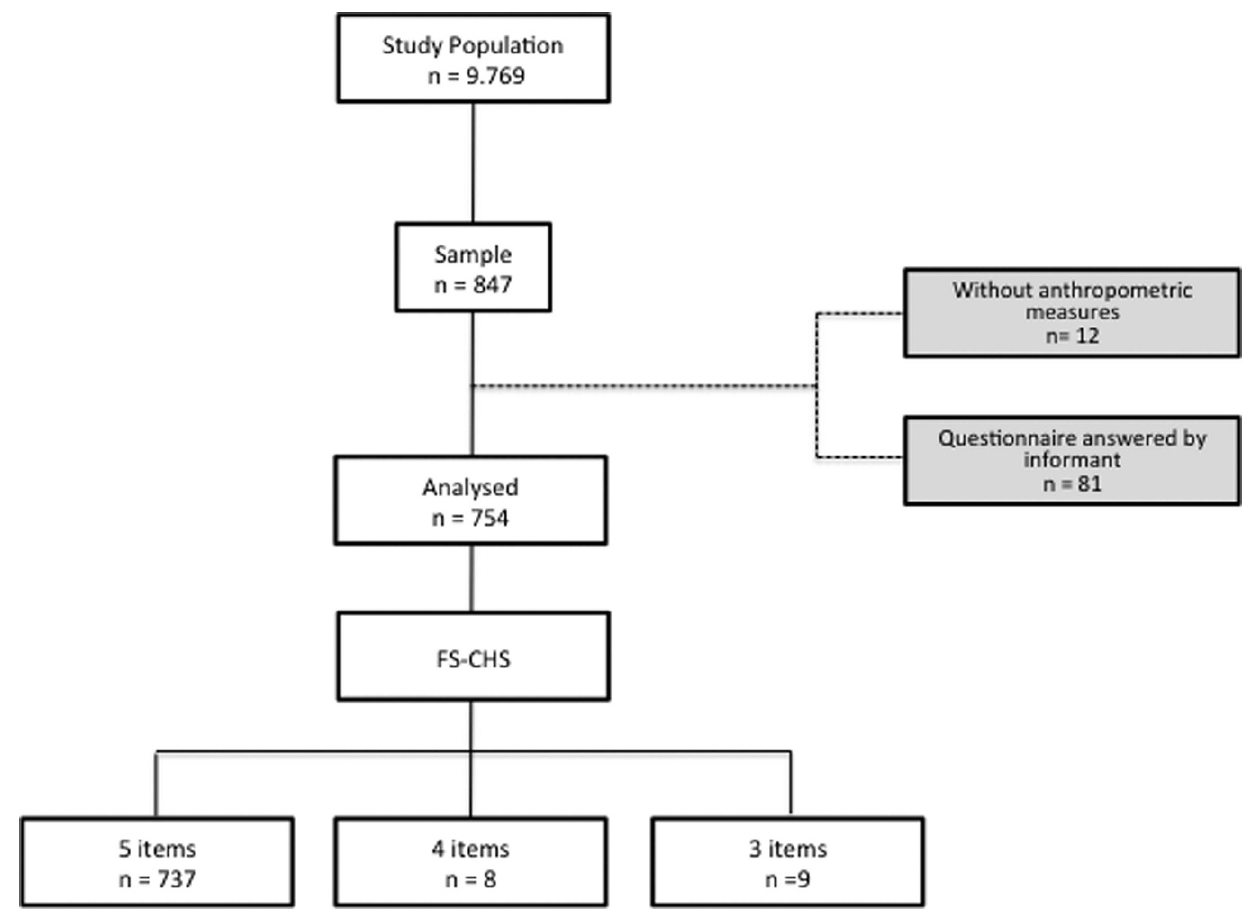
Figure 1 - Sampling selection for individuals aged 65 or older who were inhabitants of the northern region of Rio de Janeiro in